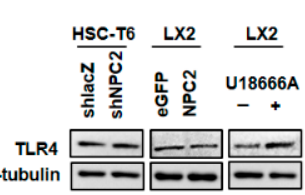
Figure 5. NPC2 expression did not alter the LPS-induced inflammatory response, while U18666A-treated HSCs amplified LPS-induced inflammation. ( A ) HSC-T6 shlacZ and shNPC2 stable cells were treated with 100 ng/mL LPS for the indicated time periods, and the lysates were subjected to Western blot analysis and detect p65 phosphorylation; ( B ) HSC-T6 shlacZ and shNPC2 cells were pretreated with 100 ng/mL LPS for 3 h, and mRNA expression of IL-1 , IL-6 , and TNF- α was analyzed using real-time PCR; ( C ) LX2 eGFP and NPC2 stable cells were treated with 10 ng/mL LPS for the indicated time periods, and the lysates were immunoblotted and then quantified to detect p65 phosphorylation; ( D ) Real-Time PCR was used to analyze mRNA expression of LPS-induced IL-1, IL-6, and TNF- α . ( E , F ) LX2 cells were pretreated with or without 1 µ M U18666A overnight to induce free cholesterol accumulation and then treated with 100 ng/mL LPS. Cell lysates were immunoblotted to detect p65 phosphorylation, while real-time PCR was used to analyze mRNA expression of LPS-induced IL-1 , IL-6 , and TNF- α ; ( G ) Protein expression of TLR4 and α -tubulin was analyzed by using immunoblotting in NPC2-downregulated HSC-T6, NPC2-overexpressed LX2, and U18666A-treated LX2 cells. Data are shown as mean ± SD. ** p < 0.01 vs. black bar. Each experiment was performed using three independent replicates. A similar phenomenon was observed. Therefore, representative data are shown in the